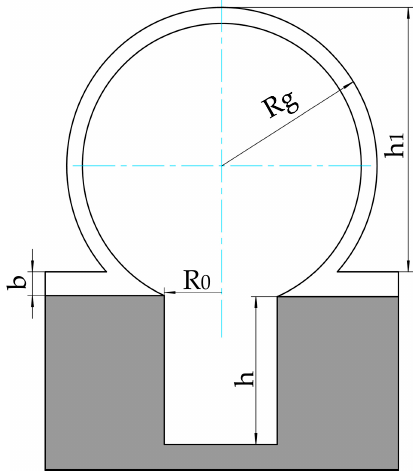
Figure 3. Height model of a micro glass-blown shell.